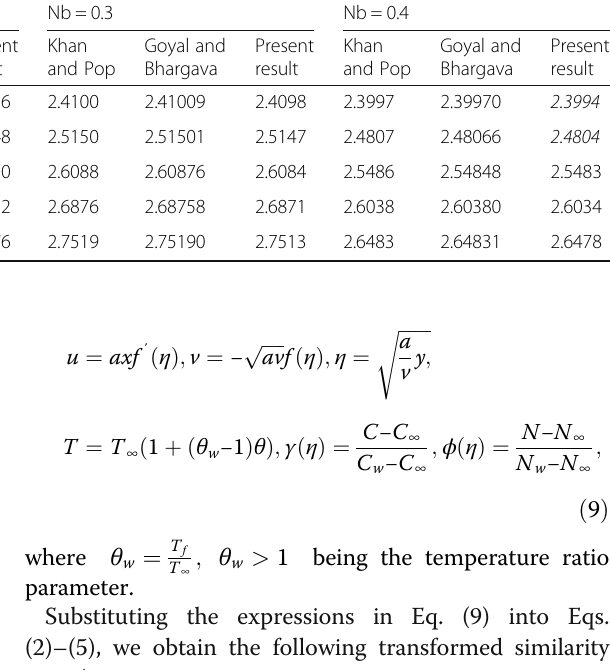
Table 3 Comparison of the results for the nanoparticle Sherwood number ( – ϕ ′ (0)) when Ln = Pr = 10 and Nd = Le = Ld = α = λ = 0, Bi = 1 , M = 1.5 , Nc = 0.1 , R = 1 , θ w = 1